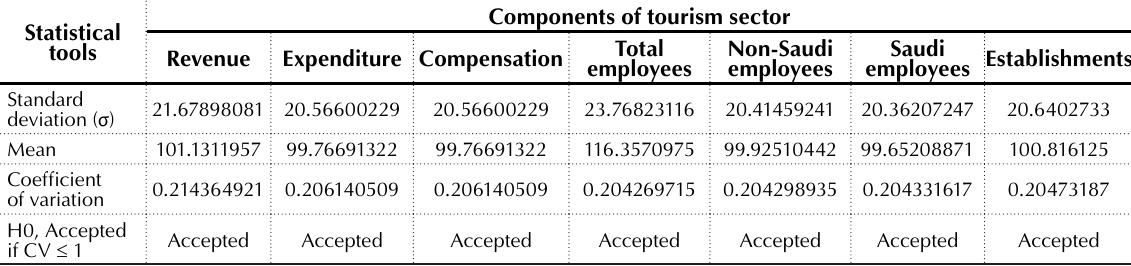
Table 1. Results of analysis Source: Tourism publication of General Authority for Statistics website of Saudi Arabia,